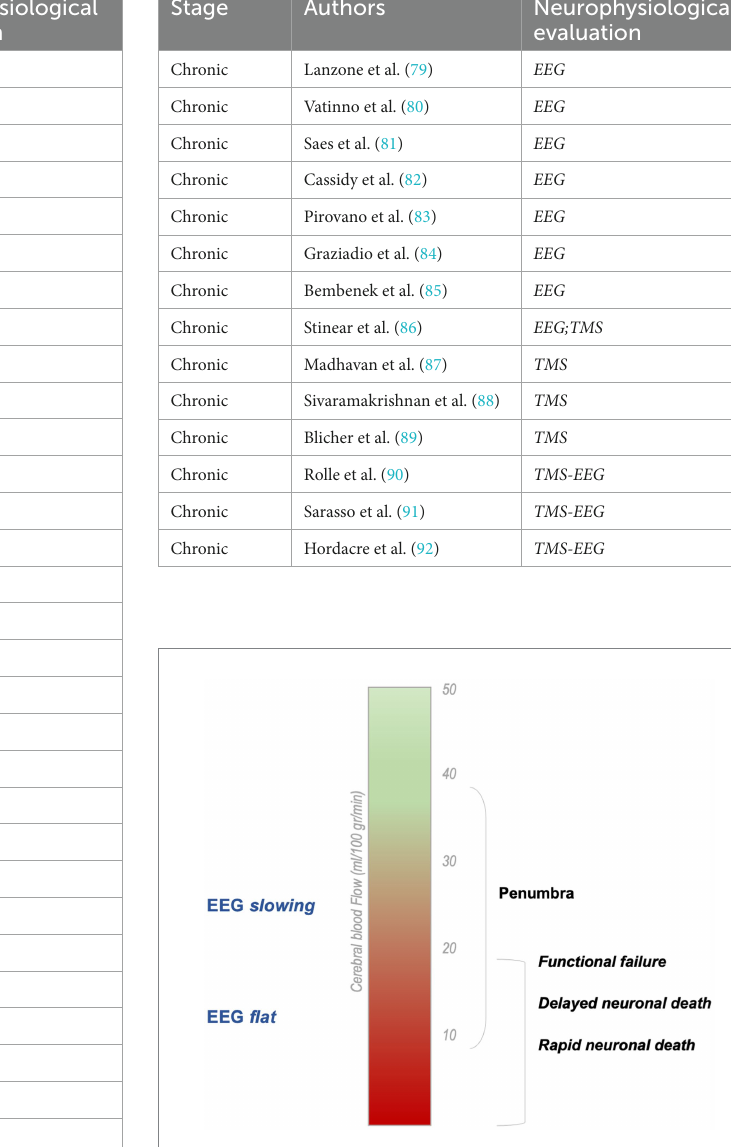
FIGURE 2 Cerebral blood flow related to Electroencephalographic findings in acute stroke [modified from Hofmeijer and Van Putten (9)]. In acute ischemic stroke, EEG signal changes according to CBF reduction. The infarcted area—where the damage is irreversible—is typically electrically silent on EEG.